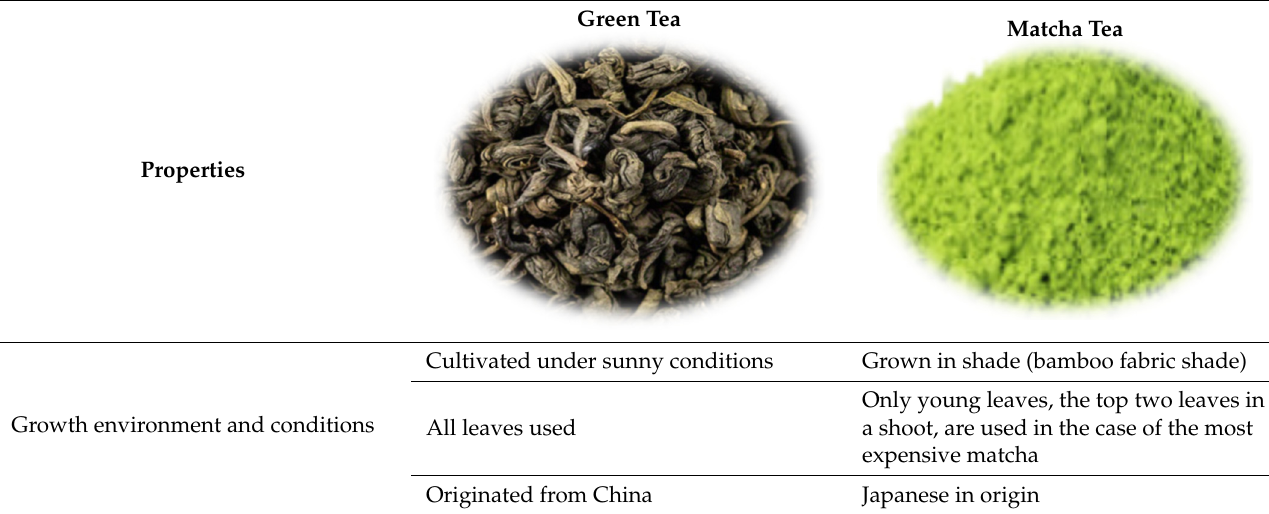
Table 1. Comparative account of green tea versus matcha tea.